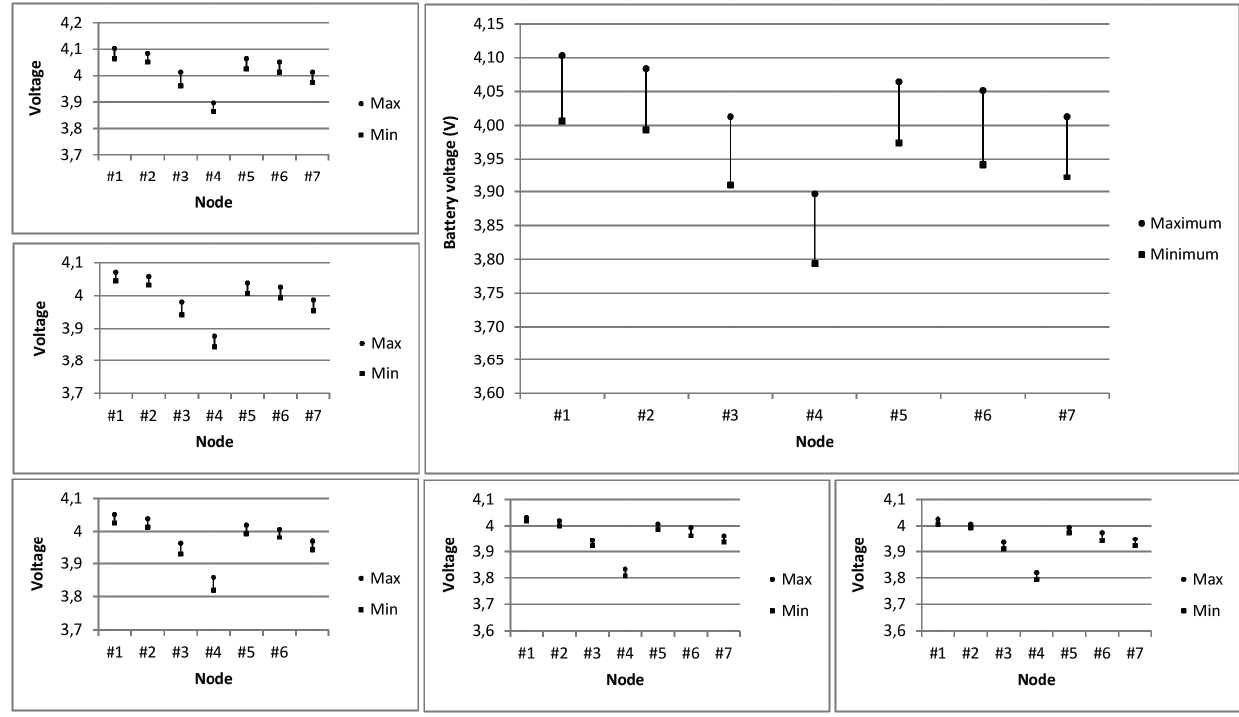
Figure 23. Battery voltage by node and experiment, and final battery voltage after 50,000 iterations (large